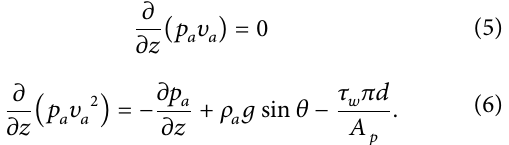
Figure 2: Schematic diagram of polymer additive CO